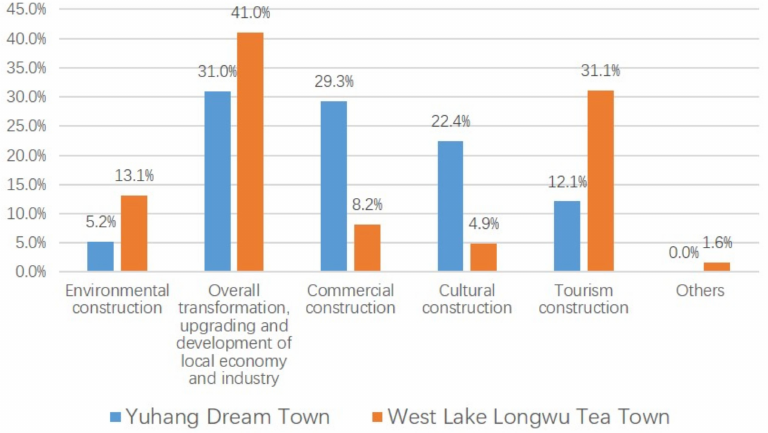
Figure 38. Opinions on the aspects that the respondents think that the local CT practice in the future needs to focus on to promote local development (source: